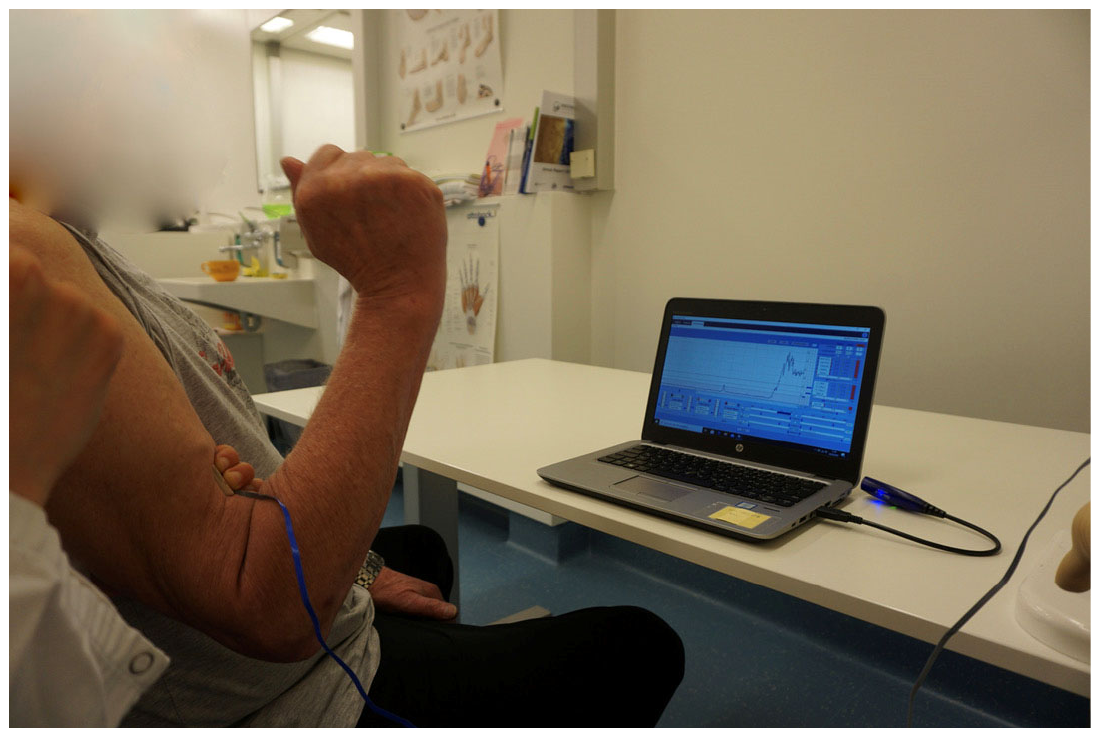
Figure 2. EMG-feedback training is a fundamental part in neuromuscular rehabilitation after nerve transfers, especially in older patients. The visualization of muscular activity facilitates relearning of muscular